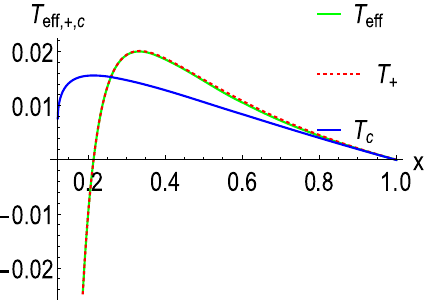
Substituting Eq. (3.11) into Eq. (3.5), (3.9) and (3.10), we plot the curves with the parameters Q = 1, ω = − 2 / 3, β + = 0 . 0005, l 2 = 37 . 386 in Fig.